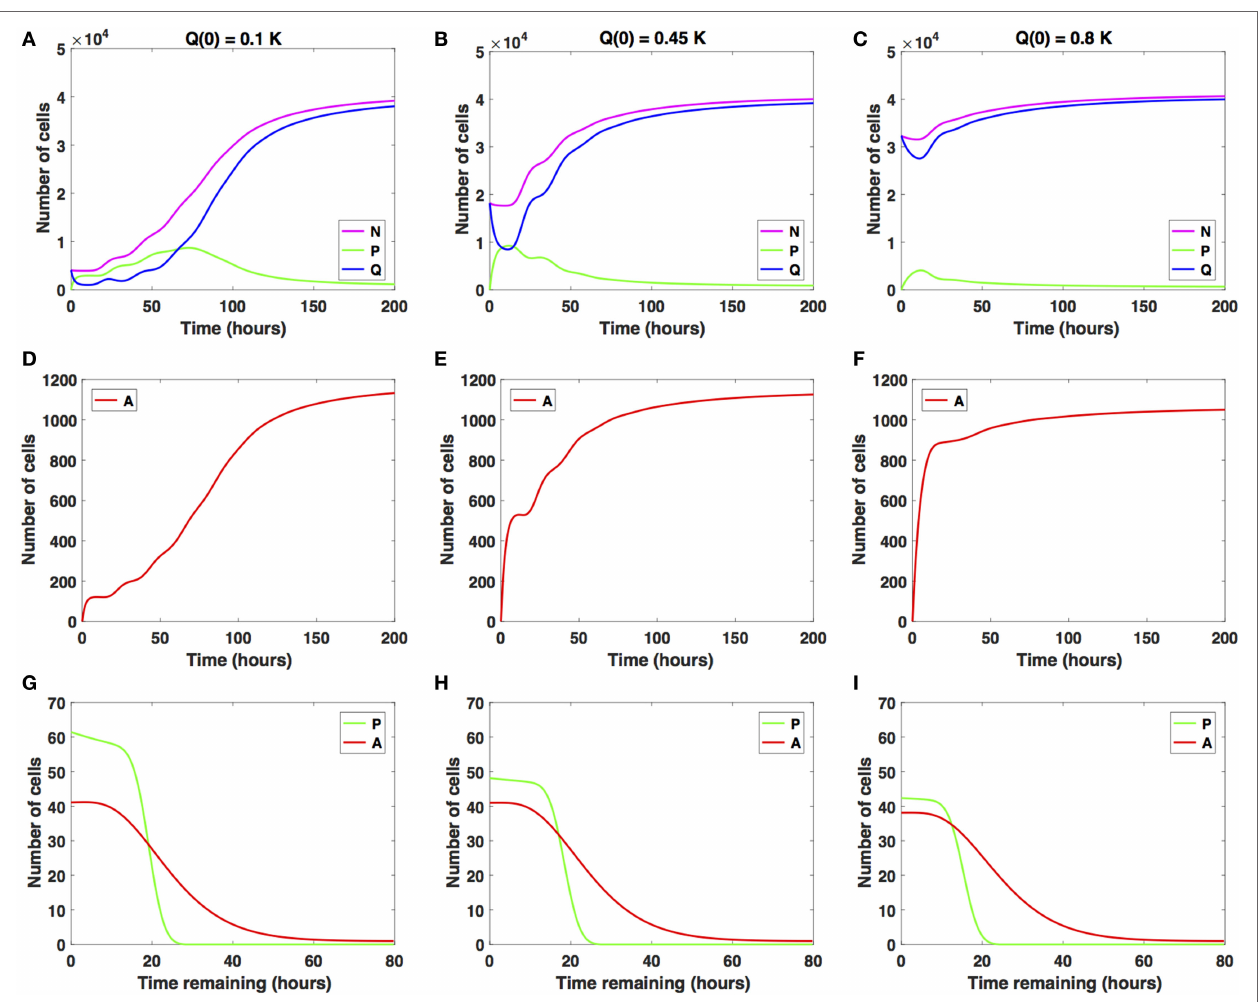
FIGURE 2 | Numerical solutions for the system (1)–(3) in the absence of the drug with (A,D,G) Q (0) = 10%, (B,E,H) Q (0) = 45%, and (C,F,I) Q (0) = 80% of the in vitro carrying capacity, K . (A–C) show the dynamics of the proliferating ( P ), quiescent ( Q ), and total number of non-apoptotic cells ( N ). (D–F) show the dynamics of the apoptotic cells ( A ). (G–I) illustrate the distribution of the times remaining to be spent by cells in the proliferative ( P ) and apoptotic ( A ) compartments as seen at the end of the simulation time, t = 200h, with (G) Q (0) = 10%, (H) Q (0) = 45%, and (I) Q (0) = 80% of plating carrying capacity, K .